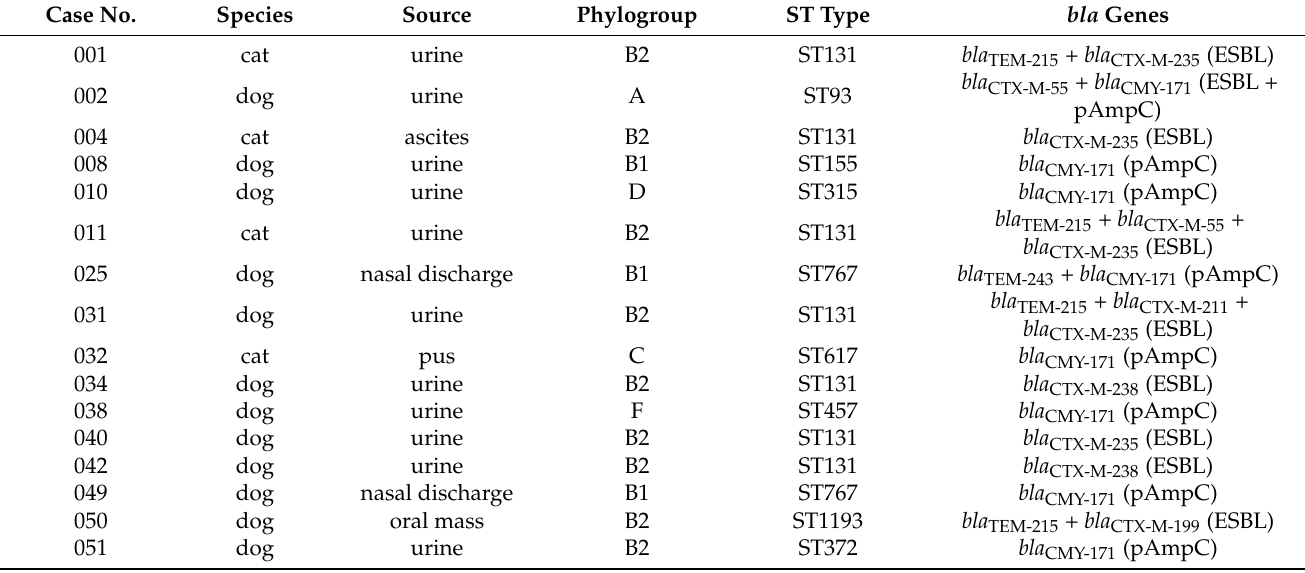
Table 1. bla genotypes, phylogroups, and ST types of ESBL/pAmpC-producing E. coli ( n = 16). Case